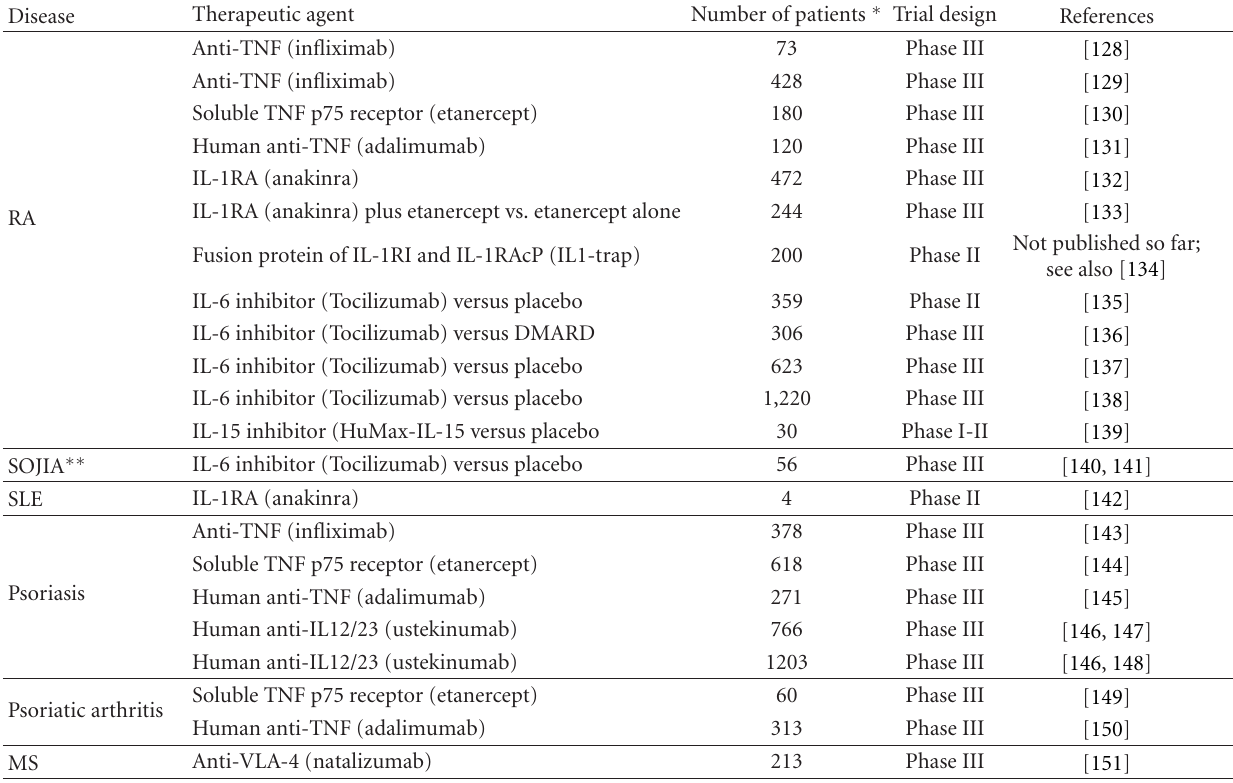
Table 3: Biologic drugs targeting cytokines or cytokine receptors in human autoimmune diseases